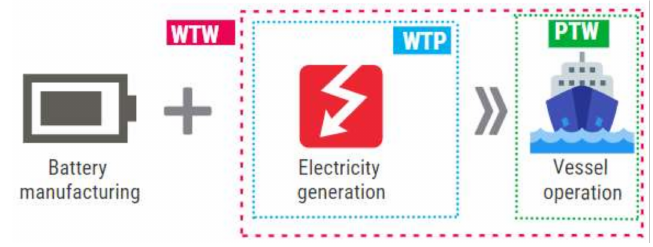
Figure 3. The life-cycle of the battery-powered ship